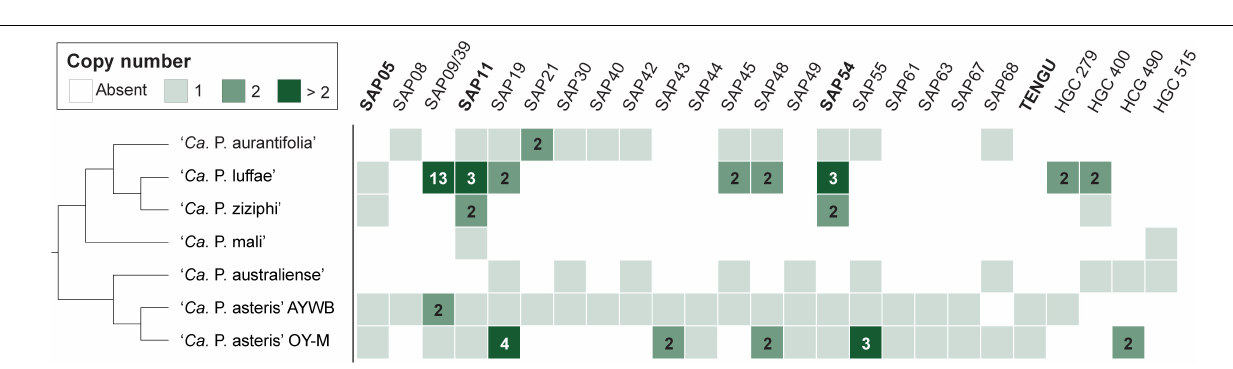
FIGURE 7 | Distribution of genes that encode putative secreted proteins among representative phytoplasmas. Only those found in at least two genomes are presented, the gene copy numbers are presented in the form of a heat map. The gene names are labeled according to the ‘ Ca . P. asteris’ isolates AYWB or OY-M annotation when available; the remaining ones are labeled according the homologous gene cluster (HGC) IDs of this work. Those effectors genes that have been experimentally characterized (i.e., SAP05, SAP11, SAP54, and TENGU) are highlighted in bold. ‘ Ca . P. aurantifolia’ NCHU2014 has two divergent SAP05 homologs (locus tags EPWB_v2c2740 and EPWB_v2c3230) that do not meet the criteria for inclusion in the